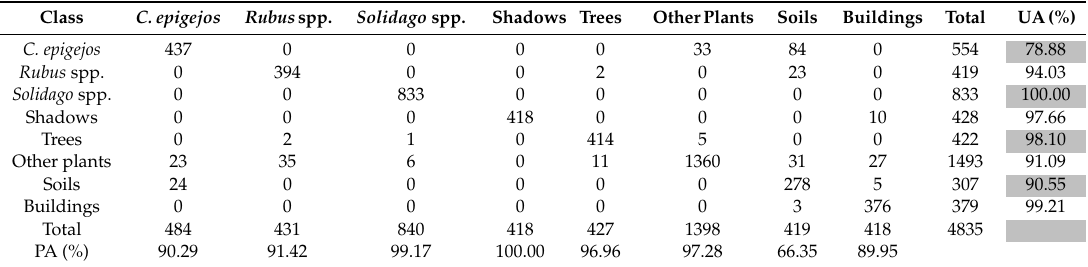
Table 4. Confusion matrix of the RF classification with 30 MNF bands and the 300 pixel training set (Kappa coe ffi cient = 0.92, OA =